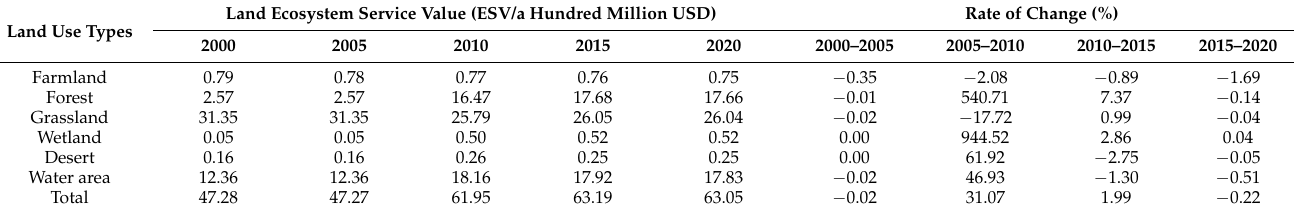
Table 8. Changes in the land ecosystem service value in Tibet’s ORTTR in 2000, 2005, 2010, 2015, and 2020.